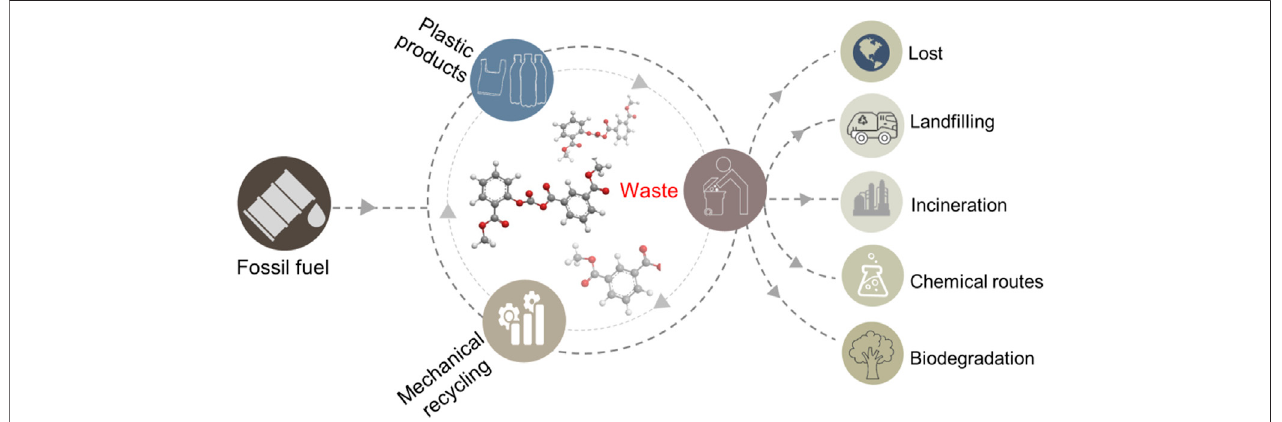
FIGURE 1 | Schematic illustration of the life cycle of